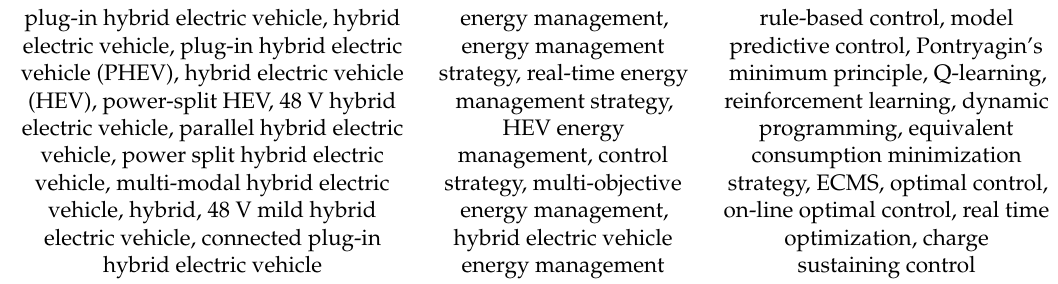
Table 2. Keywords identified for the